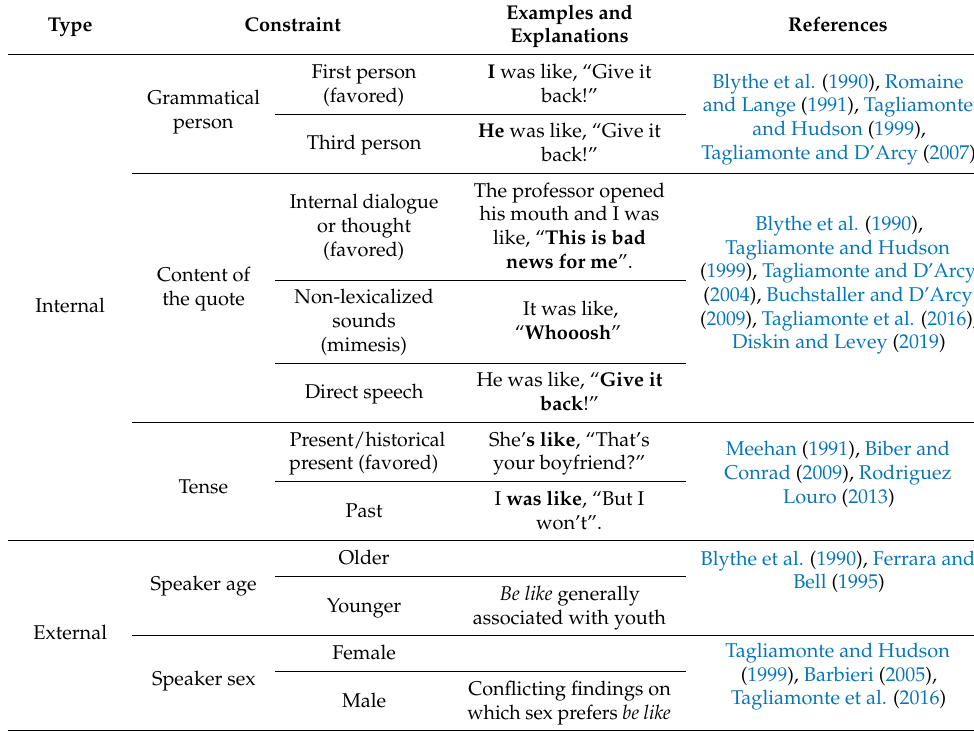
Table 2. Internal and external constraints on be like